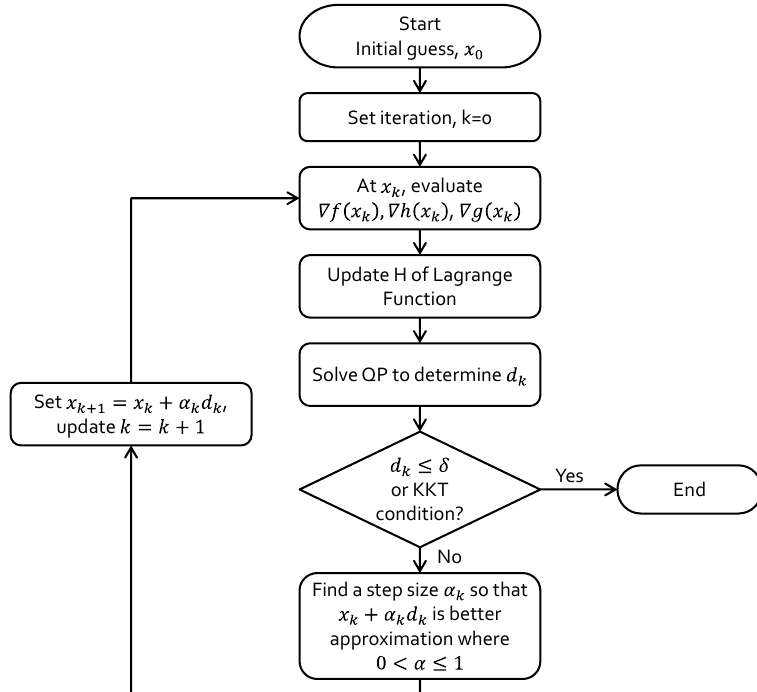
Figure 2. Calculation procedure of sequential quadratic programming (SQP) method [31–33].